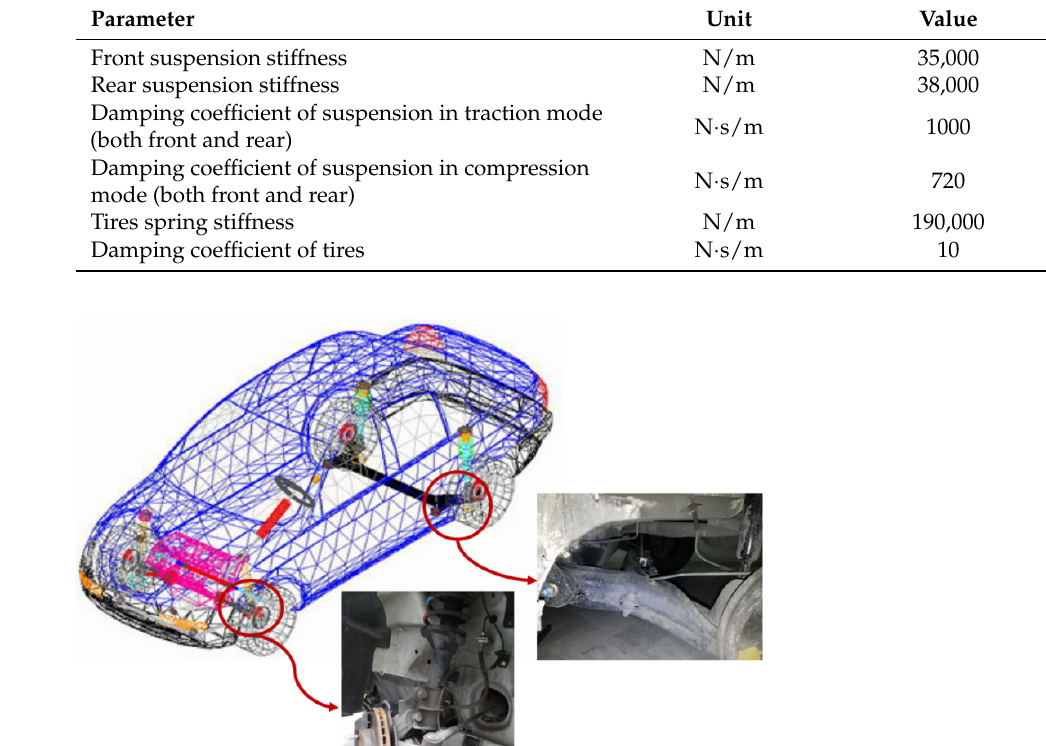
Figure 4. Full vehicle model in Adams/Car Software based on reality [56].